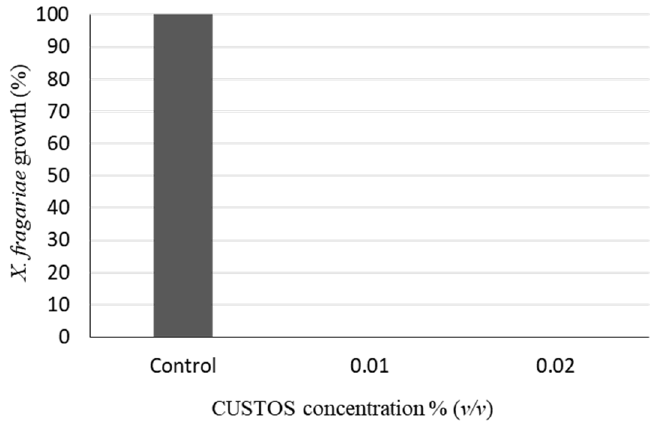
Figure 3. Inhibition by CUSTOS of bacterial growth under the lab condition. All the CUSTOS concentrations tested (0.01% and 0.02%) completely inhibited the growth of Xanthomonas fragariae. The bacterial activity was measured by optical activity (OD600) 48 h post-treatment. The experiment was repeated twice. In both cases, no bacteria were grown at 0.01 and 0.02% ( v / v ). Next, we analyzed the expression levels of the genes Dau c1.01, Dau c1.02 , and